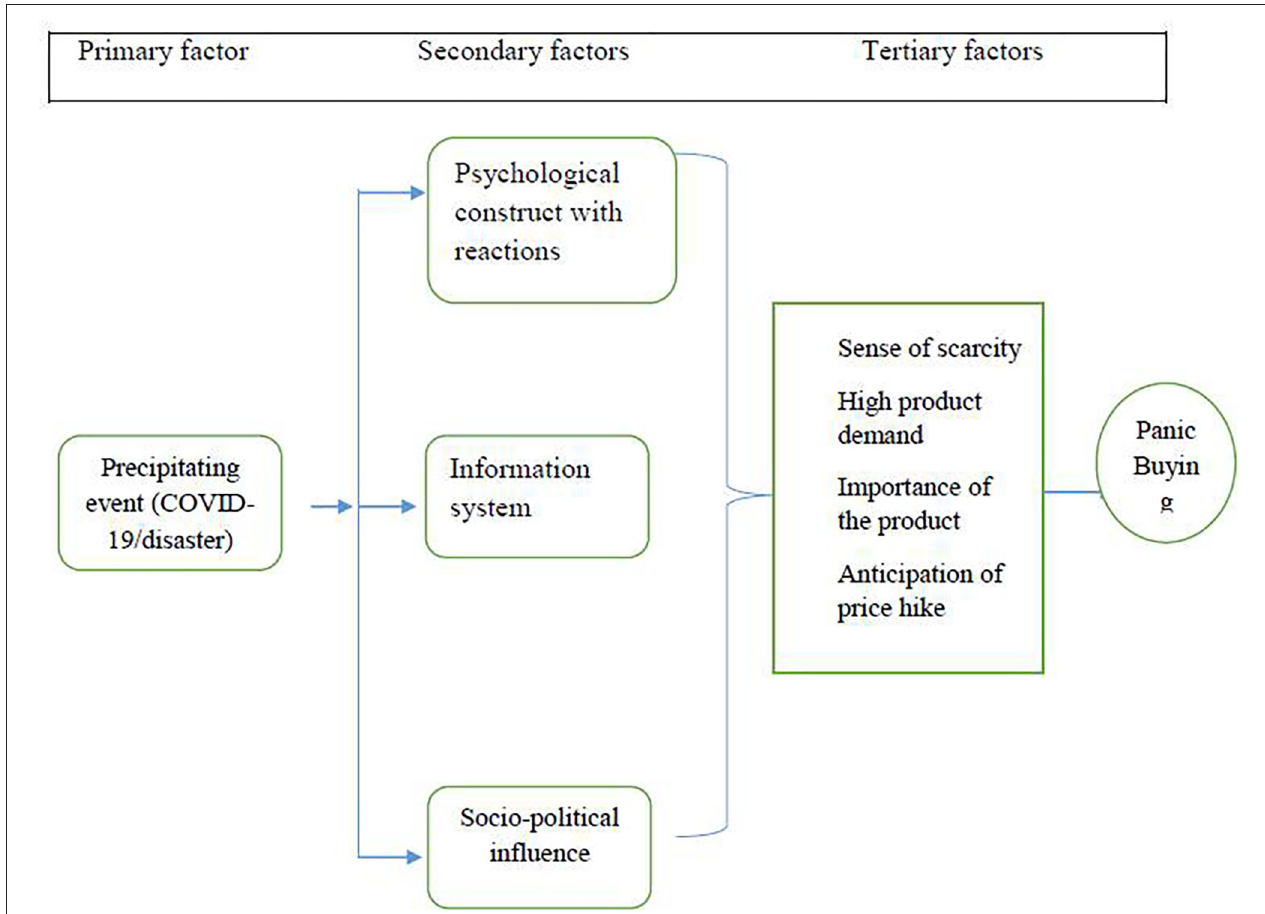
FIGURE 3 | Causal model of panic